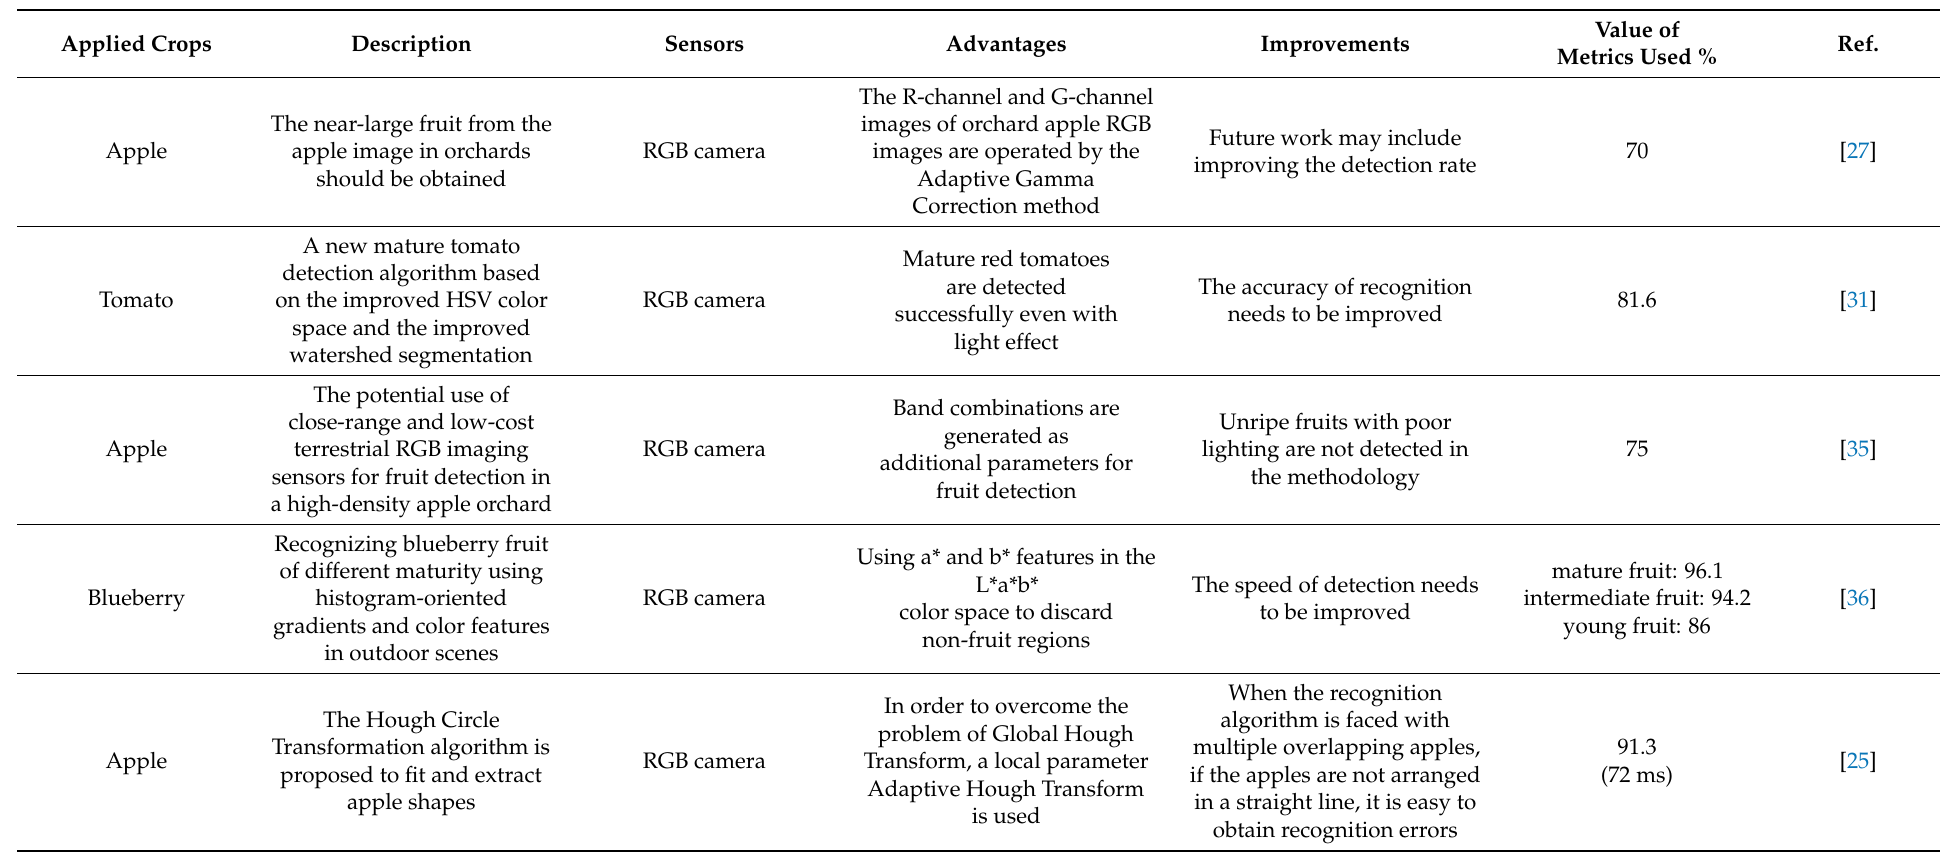
Table 2. Comparison of techniques based on digital image